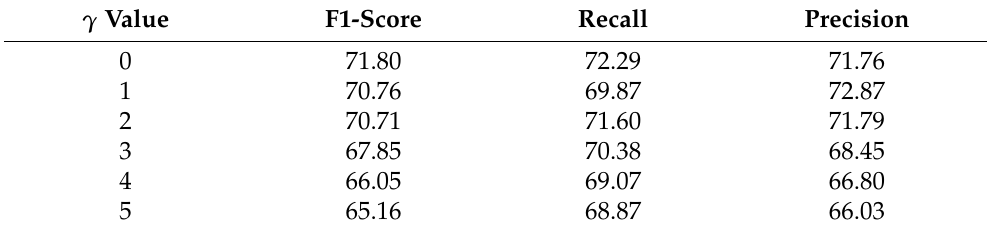
Table 4. Mean of F1-Scores, Recall, and Precision disregarding α and grouped by γ .